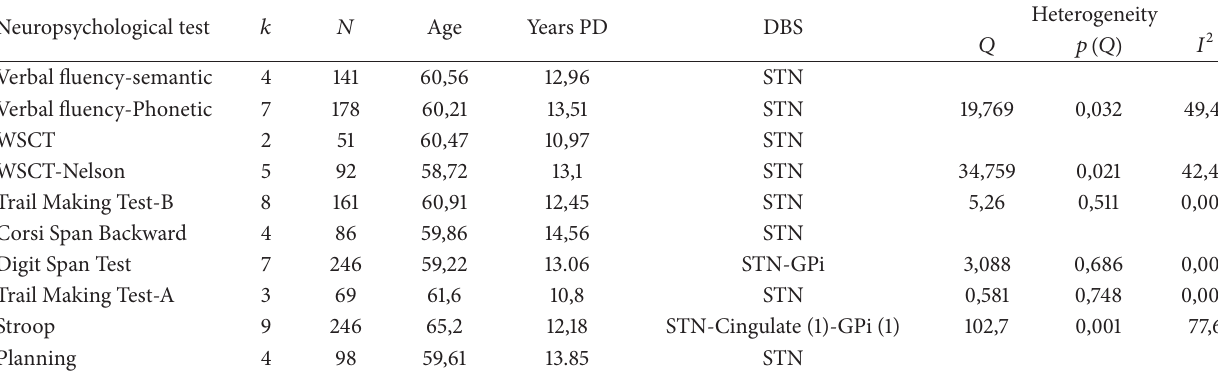
Hedges’s g Funnel plot of standard error by